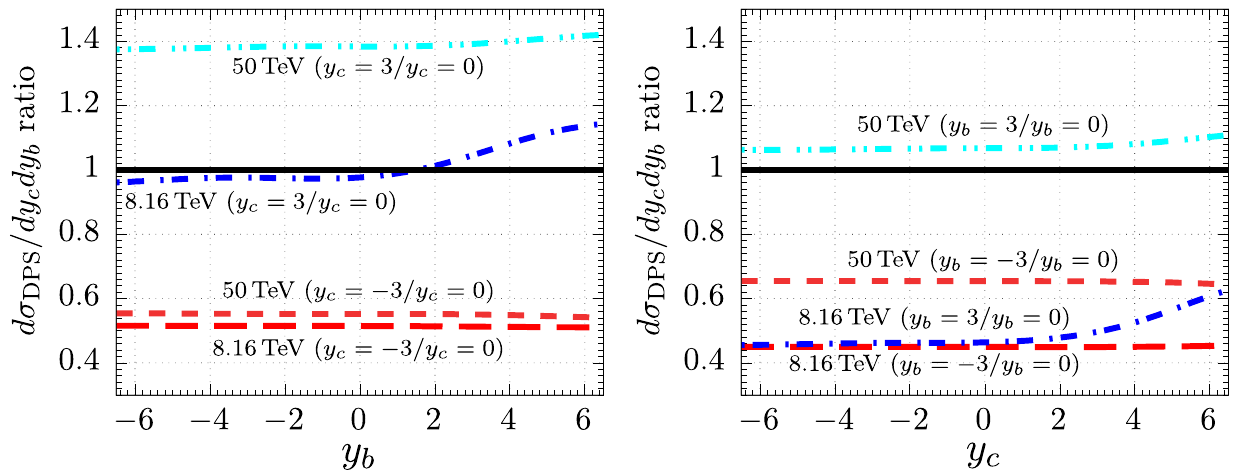
Fig. 6 The same as in Fig. 5 but for the ratios of the differential cross section at each fixed rapidity to a reference curve at fixed y c = 0 (left panel) and y b = 0 (right panel) and at each given